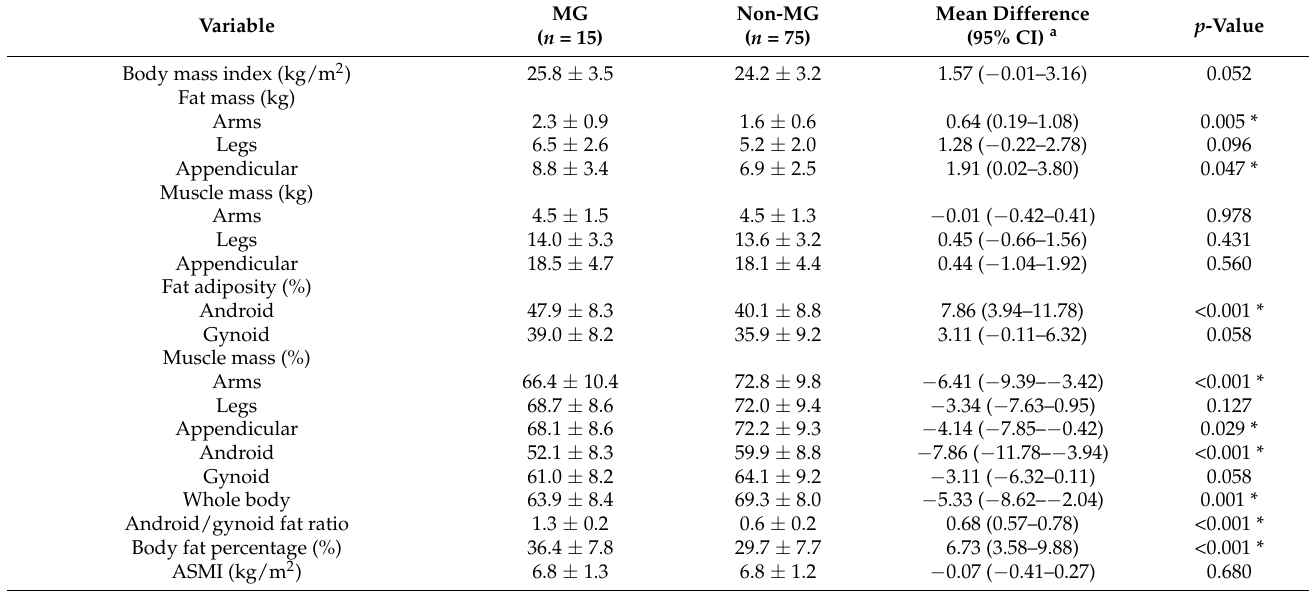
Table 3. Body composition in MG and sex- and age-matched controls aged 60–70